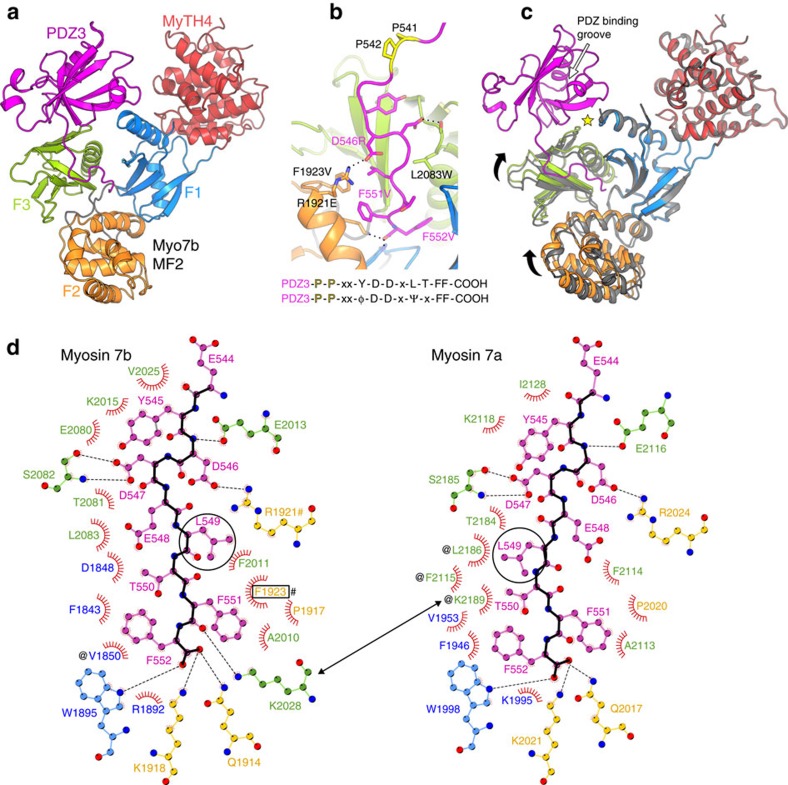
Structural basis of harmonin PDZ3c recognition by Myo7b MF2.(a) Structure of the harmonin PDZ3c-Myo7b MF2 complex. The MyTH4 domain is shown in red and the FERM subdomains are coloured in blue (F1), orange (F2) and green (F3) throughout the figures. The harmonin PDZ3c is shown in magenta. (b) Critical residues mediating interactions between the harmonin Cter extension (magenta) and the Myo7b FERM (ribbon representation) domain. Important side chains are shown in sticks. Two conserved prolines (P541 and P542) at the end of the PDZ3 domain help direct the Cter extension. The motif that mediates binding to the FERM domain is shown (bottom). (c) Superimposition of the free (dark grey) and PDZ3c-bound (multi-coloured) Myo7b MF2 structures using the F1 lobe as a reference. The black arrows indicate the lobe displacements upon PDZ3c binding. The white arrow in the PDZ3 domain indicates the partner-binding groove within the PDZ3 domain. The yellow star highlights the interface between the PDZ3 domain and the Myo7b F1 and F3 lobes. The minor changes in the orientation of the three lobes (<5°) promote optimal interactions between the Cter peptide and the FERM domain via an induced fit of small amplitude. (d) Diagram of the interactions between the harmonin PDZ3 Cter extension (magenta, black backbone) and the Myo7 FERM domain. Dotted lines: hydrogen bond within distances <3.5 Å; Red spikes: hydrophobic interactions. The major difference between the two complexes is in the orientation of harmonin L549 side chain (black circles) due to the F1923Myo7b (black box)/Y2026Myo7a substitution. The following residue, T550, also changes its environment (# denotes residues interacting with L549, while @ indicates residues interacting with T550). The black arrow indicates the homologous lysines 2086/2189 (Myo7b/Myo7a) that interact differently with PDZ3c. This figure is generated using LigPlot+69.